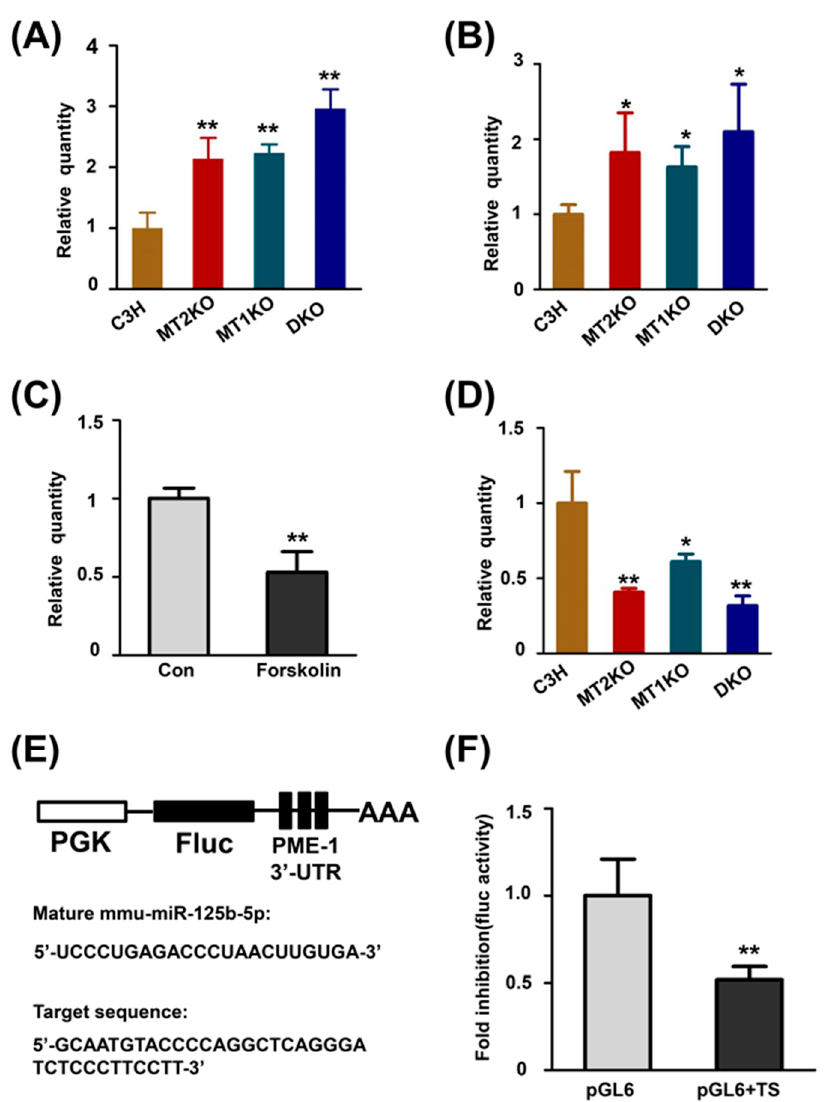
Figure 5. MiR-125b-5p interferes with the translation of PME-1 by binding to its 3 ′ UTR. ( A ) Relative quantity of Ppme1 by RT-PCR in C3H and three transgenic mice. ( B ) Relative quantity of cAMP by ELISA in C3H and three transgenic mice. ( C ) Relative quantity of miR-125b-5p by RT-PCR in HEK293 with or without forskolin. ( D ) Relative quantity of miR-125b-5p by RT-PCR in C3H and three transgenic mice. ( E ) pGL6 plasmid with partial sequence of PME-1 ′ s 3 ′ UTR. PGK, promoter; Fluc: irefly luciferase; AAA: polyA tails. The mature mmu-miR-125b and target sequence are shown at the bottom. ( F ) Fold inhibition of firefly luciferase by miR-125b. TS, target sequence. * p < 0.05, compared with C3H; ** p < 0.01, compared with C3H. Data are presented as means ± SD.